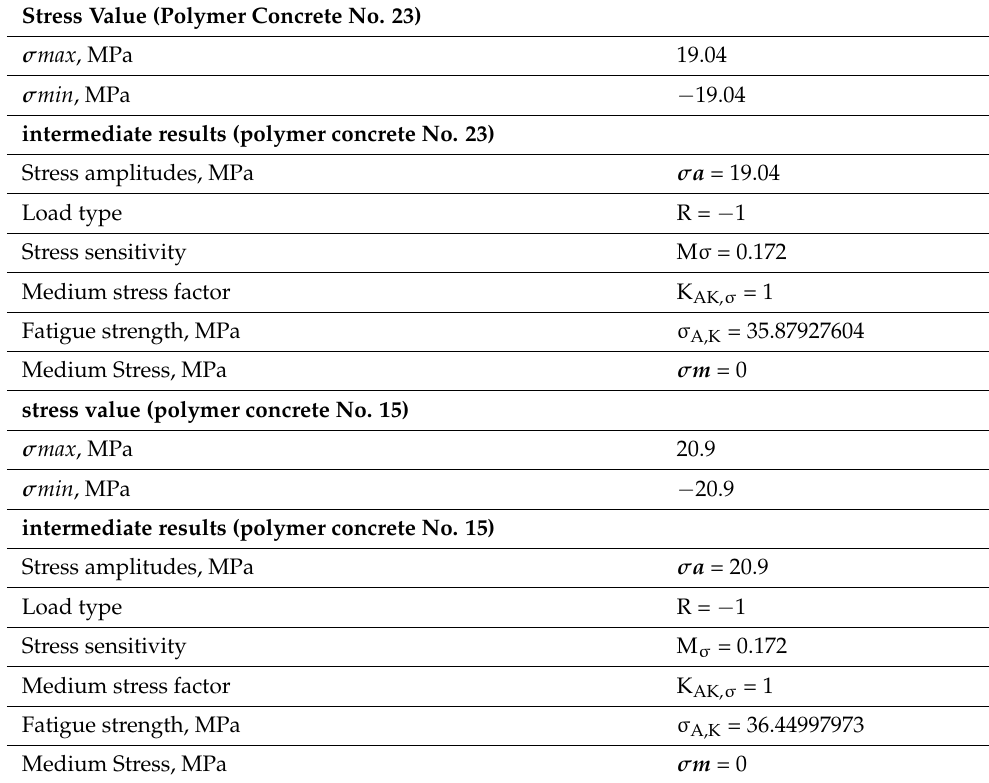
Table 6. Results of calculating the internal stress